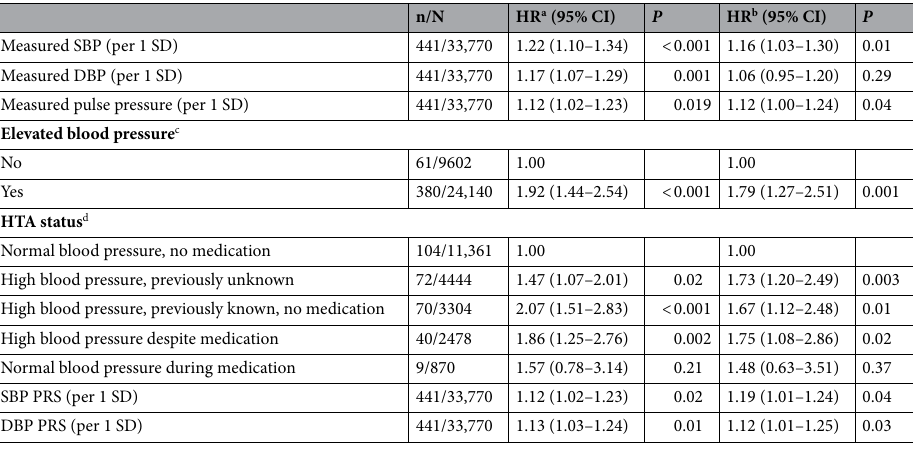
Table 2. Associations between hypertension and liver-related outcomes using both measured blood pressure, use of antihypertensive medication and polygenic risk scores (PRSs). Analyses are by Cox regression analyses. CI, confidence interval; HR, hazards ratio; HTA, arterial hypertension; SBP, systolic blood pressure; DBP, diastolic blood pressure; PRS, polygenic risk score. a Adjusted for age and sex. Analyses including polygenic risk scores (PRS) are additionally adjusted for genotyping chip and the first three principal components of genetic structure. b Adjusted for age, sex, body mass index, waist circumference, weekly alcohol use, fraction of alcohol use as wine, low-density lipoprotein cholesterol, high-density lipoprotein cholesterol, triglycerides, diabetes, exercise habits, smoking status (current, former, never smoker) and baseline cardiovascular disease. Analyses including polygenic risk scores (PRS) are additionally adjusted for genotyping chip and the first three principal components of genetic structure. c Either measured blood pressure ≥ 130 (systolic) or ≥ 85 (diastolic) mmHg or antihypertensive medication use at baseline. d High blood pressure defined as ≥ 140 (systolic) or ≥ 90 (diastolic) mmHg.